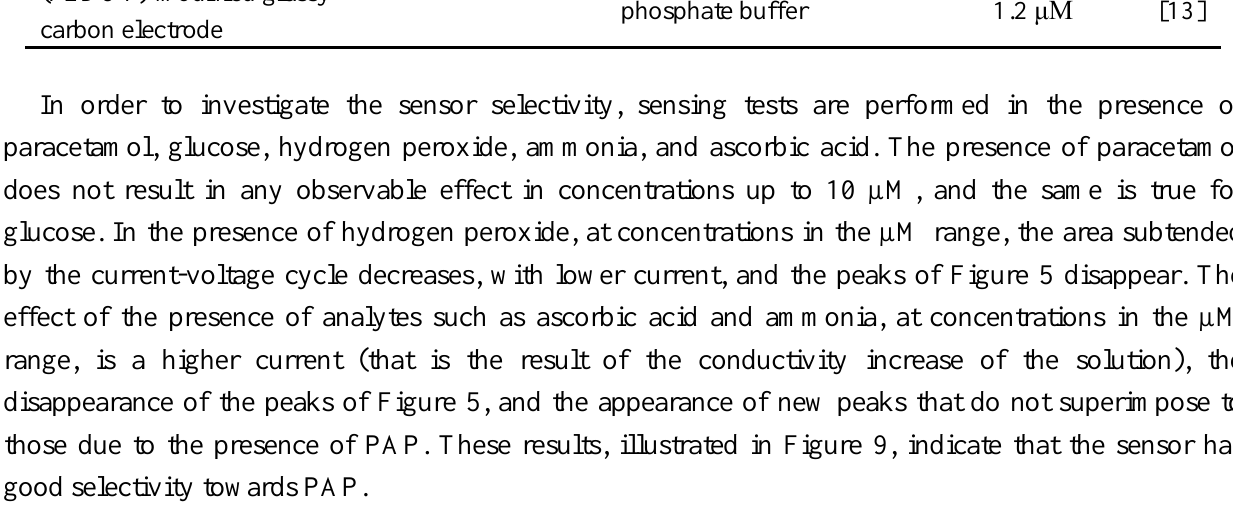
Figure 9. Current-voltage cycles measured in the same operating conditions used for the other sensing tests, in deionized water and in the presence of 5 µM hydrogen peroxide (black line), of 5 µM ammonia (red) and of 5 µM ascorbic acid